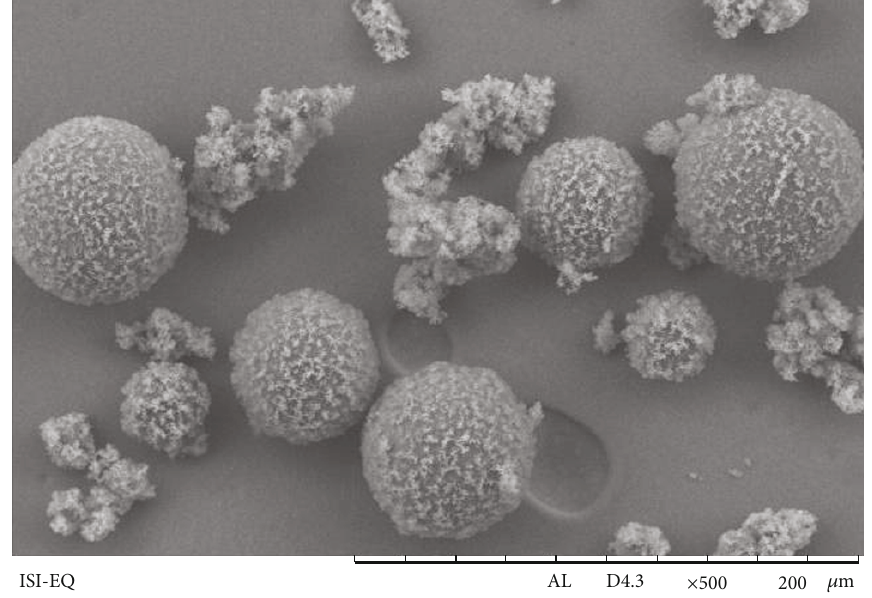
Figure 3: SEM images of tung oil